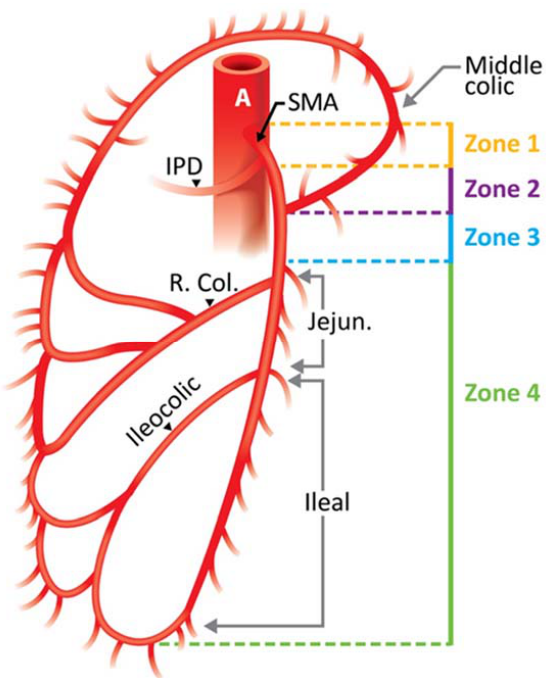
Figure 6. Fullen Anatomic Classification of Superior Mesenteric Artery. A: Aorta; SMA: Superior mesenteric artery; IPD: Inferior pancreaticoduodenal artery; R. Col: Right colic artery. Table 2. Fullen Anatomic Classification of Superior Mesenteric Artery [30].